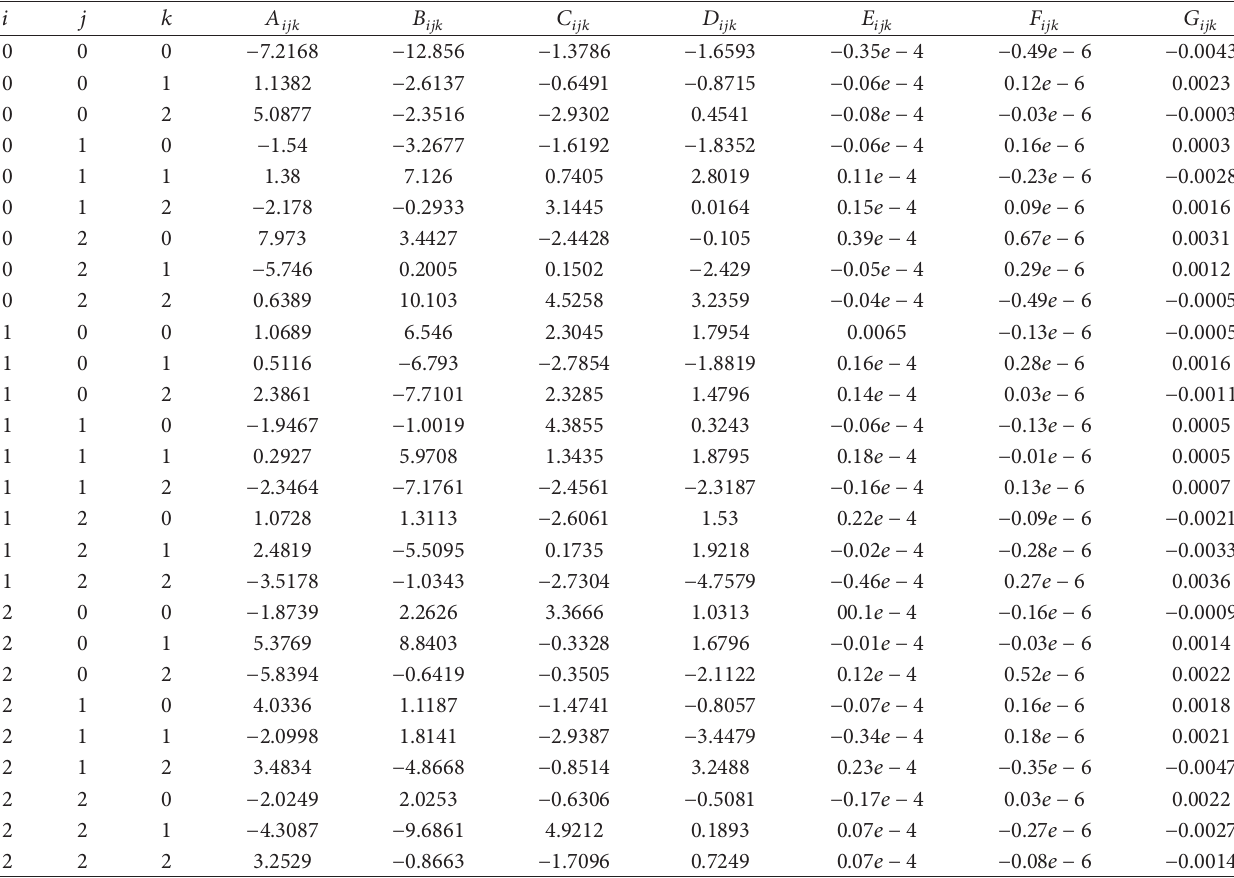
Table 3: Coefficients of Poisson’s ratios, elastic modulus, and density ratio functions obtained from (5) to